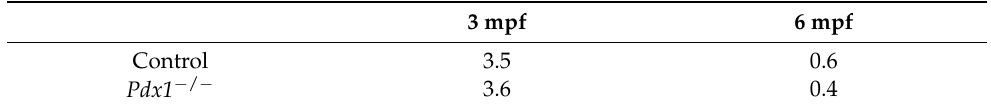
Figure 6. pax6 -expressing progenitors are not increased in chronic hyperglycemia. Tg(pax6b:dsRed) labeled cells (magenta) in the INL ( a , b ) and the CMZ ( e , f ) in 3 mpf control and pdx1 − / − mutant retinas. Proliferating cells are labeled through EdU incorporation (green). In 6 mpf controls ( c , g ) and pdx1 − / − mutants ( d , h ), pax6b:dsRed expression was not observed in the central area of the retina and was limited to few cells in the CMZ. In situ hybridization for pax6a stained cells in the basal portion of INL in the central area of the retina ( i–l ) and in the CMZ ( i’–l’ ) in controls ( i , i’ , k,k’ ) and pdx1 ‐ / ‐ mutants ( j , j’,l,l’ ) at 3 mpf and 6 mpf. Scale bar: 50 μ m. (GC, ganglion cell layer; INL, inner nuclear layer; ONL, outer nuclear layer). Table 1. Double positive pax6:dsRed, EdU stained cells in the CMZ per section (at least 3 sections per individual, n = 2 fish per time point).